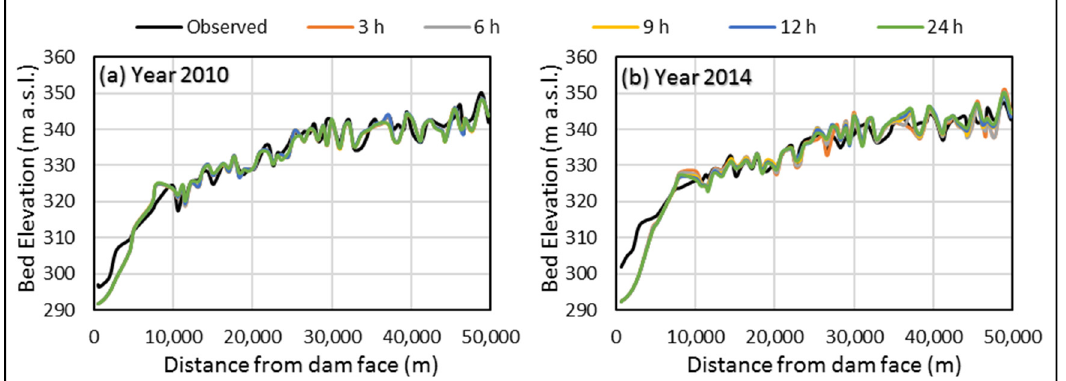
Figure 10. Comparison of observed and simulated bed elevation for different computational increments.